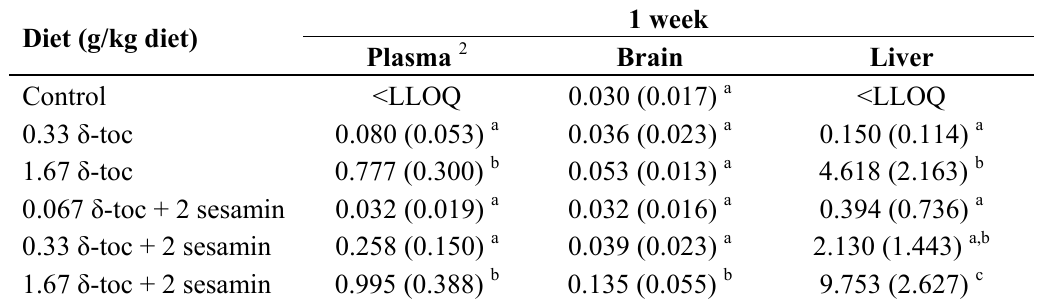
Table 1. Concentration (µM) of δ -toc in plasma, brain, and liver of Balb/cJ mice following 1 week dietary supplementation with δ -toc or δ -toc plus sesamin 1